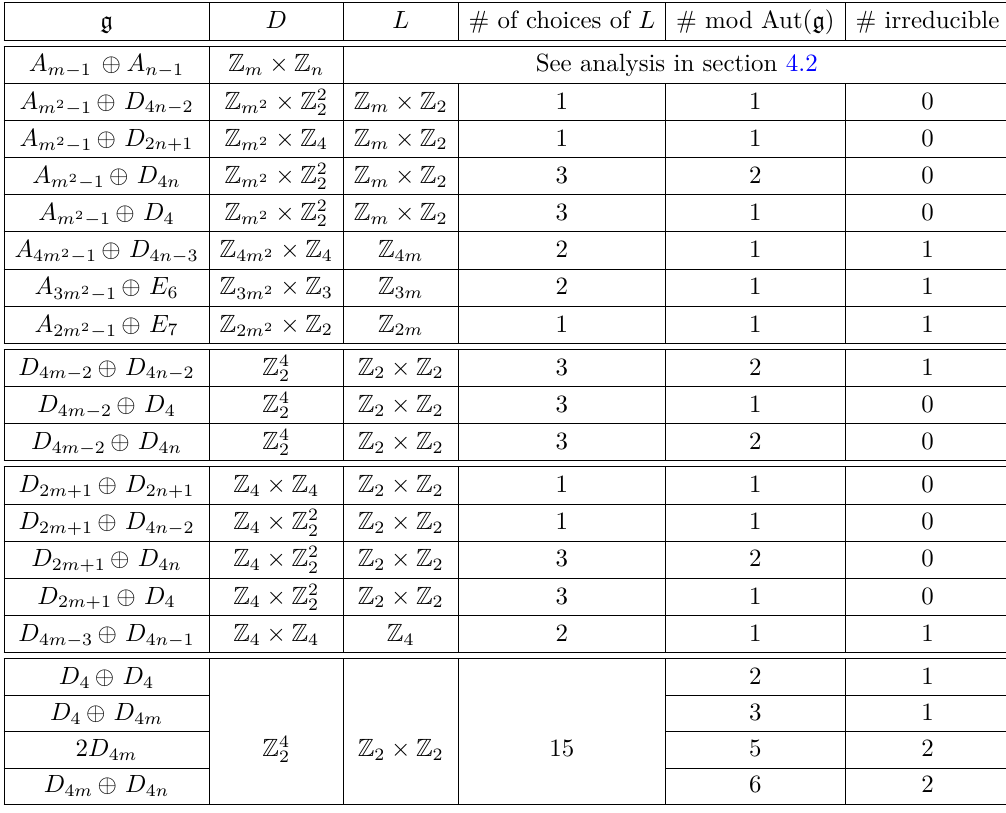
Table 1 . Classification of absolute 6d (2 , 0) theories labeled by g = g 1 ⊕ g 2 a sum of two